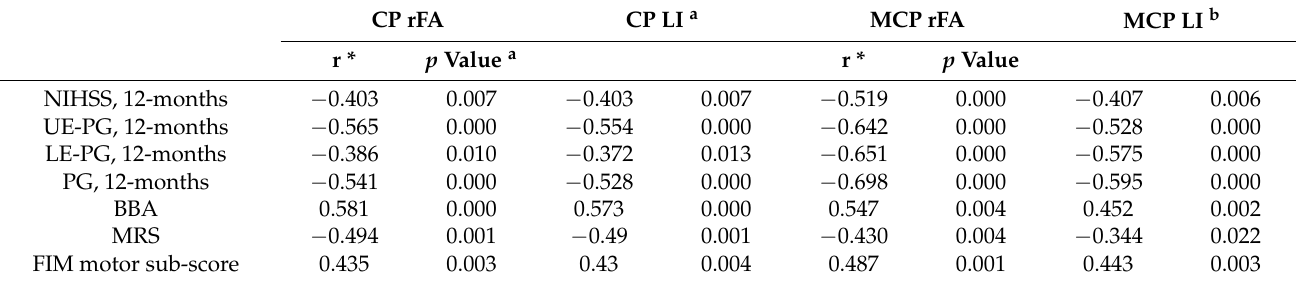
Table 3. Statistical analysis comparing the FA ratio and Laterality Index obtained at CP and MCP as well as the clinical scores. CP rFA CP LI a MCP rFA